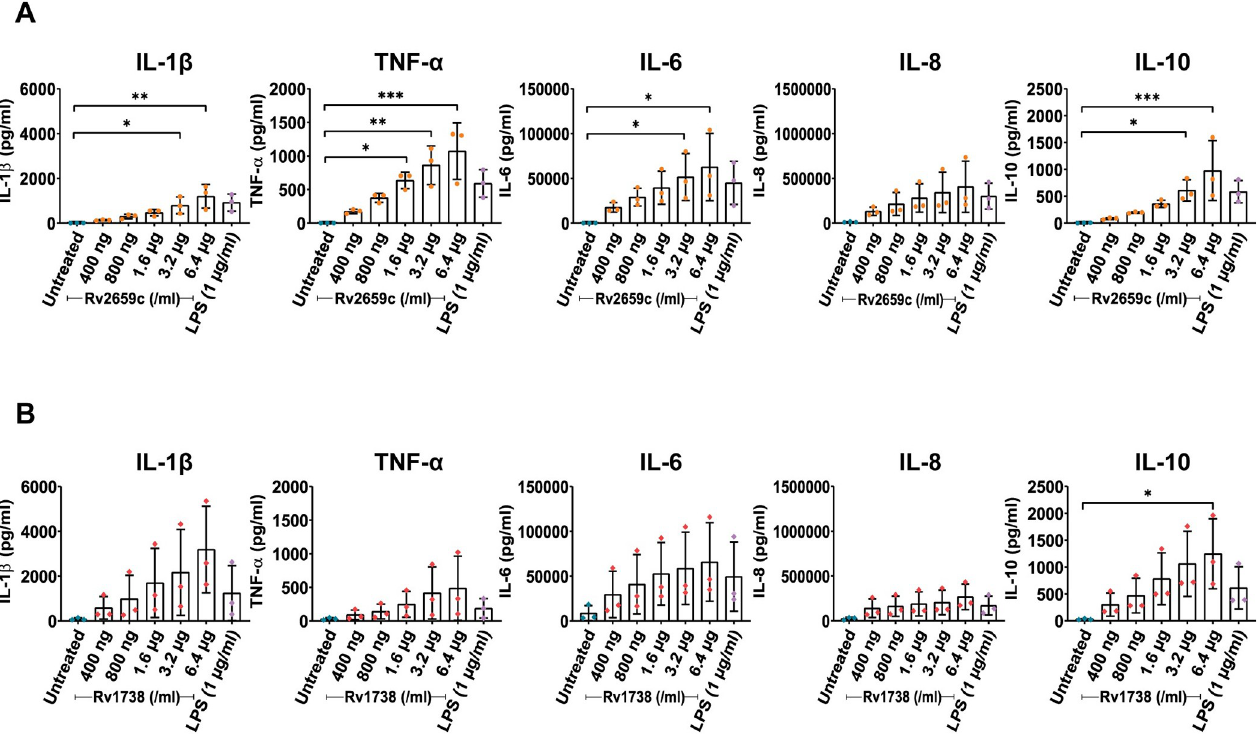
Fig 3. Recombinant proteins Rv2659c and Rv1738 induced a set of pro- and anti-inflammatory cytokines in hPBMCs. (A) Cytokine production stimulated by protein Rv2659c. (B) Cytokine production stimulated by protein Rv1738. Human PBMCs were treated with different concentrations of the proteins (400 ng/ml, 800 ng/ml, 1.6 μ g/ml, 3.2 μ g/ml and 6.4 μ g/ml) for 24 hours. Untreated cells served as the negative control, while LPS (1 μ g/ml) served as the positive control. CBA assay was performed to detect IL-1 β , IL-6, IL-8, IL-10 and TNF- α in the culture supernatants. Data were acquired by flow cytometry, analyzed by FCAP array software and represented as mean ± SD of 3 individual subjects (each experiment was done in duplicate). One-way ANOVA with Dunnett’s multiple comparison test was performed for statistical analysis. p values are represented with asterisk symbols ( � p < 0.05 �� p < 0.01, ��� p < 0.001 and ���� p <